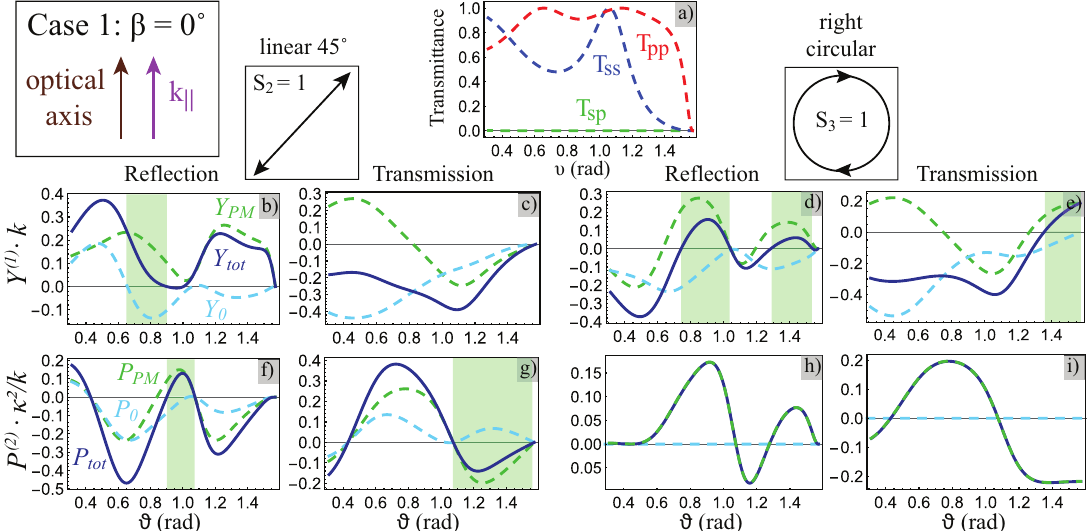
Figure 2. Case 1: the optical axis of the QWP is parallel to beam incidence plane ( β = 0 ◦ ). ( a ) co-polarized (blue and red lines) and cross-polarized (dashed green line) transmittances ( T ij = | f t for a central plane wave. ( b – i ) linear ( b – e ) and angular ( f – i ) IF shifts in reflection ( b , f , d , h ) and transmission ( c , g , e , i ) configurations for the linear at 45 ◦ ( b , c , f , g ) and right-handed circular ( d , e , h , i ) polarization characterized by the Stokes parameters S 2 = 1 and S 3 = 1, respectively. Dashed cyan and solid blue lines correspond to the standard (Equation (7) for linear and Equation (11) for angular) and total (Equation (10) for linear and Equation (14) for angular) IF shifts, respectively. The total one takes into account the PM contribution (Equation (8) for linear and Equation (12) for angular) shown by the dashed green line. The green regions in subfigures ( b , d , e , f , g ) mark the areas, where total and standard IF shifts have opposite